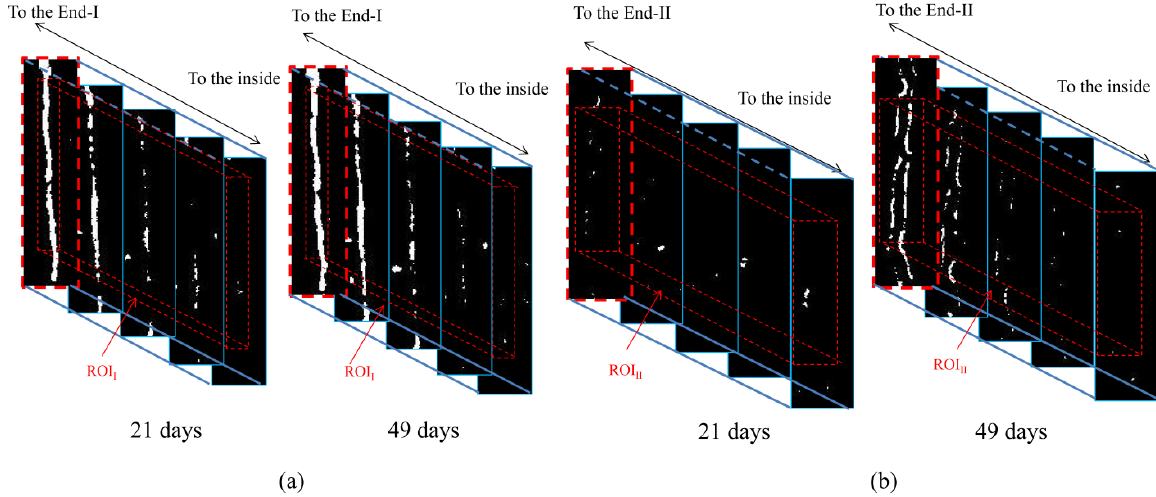
Figure 7. Binarized images obtained by segmentation of subtraction images in Figure 6 for ( a ) End-I and ( b ) End-II. Height and width of each subtraction image are ( a ) 2.9 and 0.7 mm; and ( b ) 3.5 and 0.9 mm,